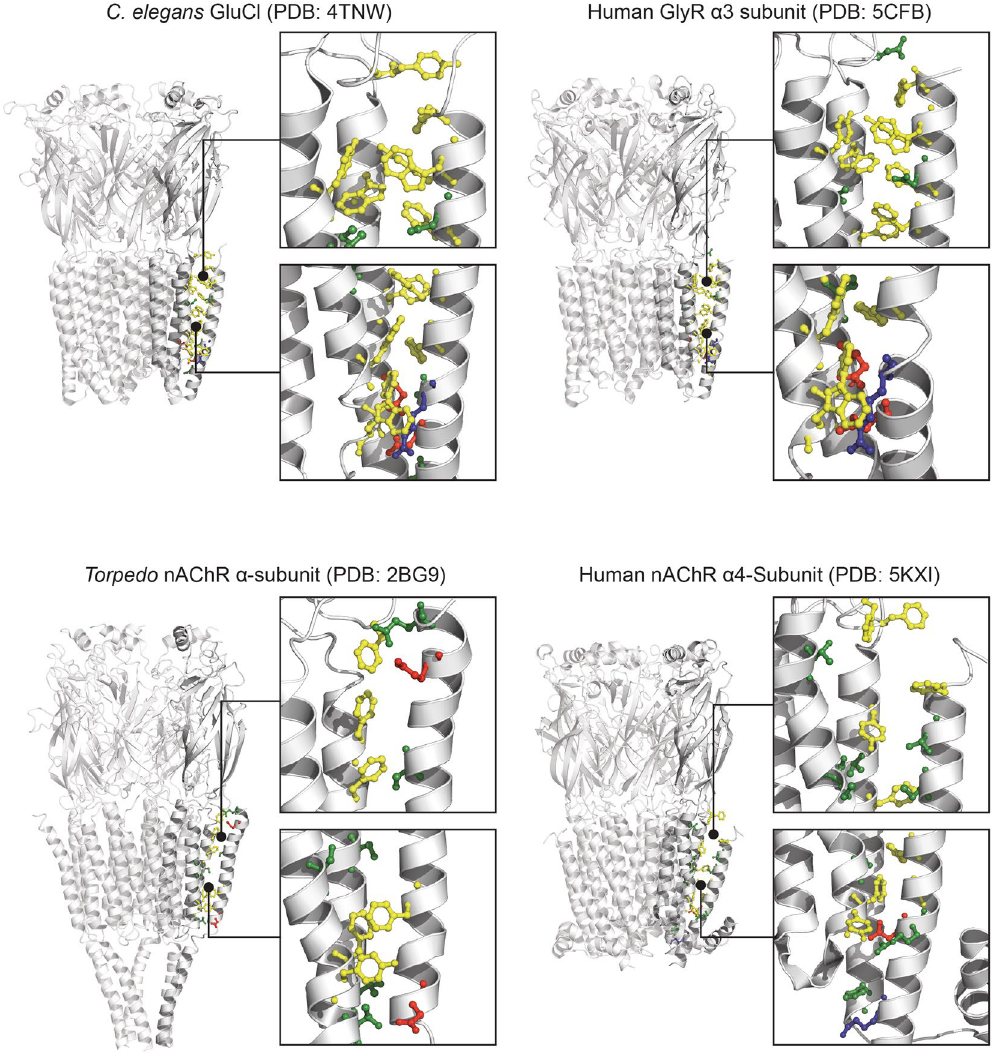
Figure 5. The M4-M1/M3 interface of different pLGICs. Structures of GluCl (top left, PDB: 4TNW), GlyR (top right, PDB: 5CFB), nAChR (bottom left, PDB: 2BG9), and α 4 β 2 (bottom right, PDB: 5KXI). Each structure shows a zoomed in region of the M4-M1/M3 interface of a single subunit. Residues are coloured depending on their properties: aromatic (yellow), hydrogen bonding (green), negatively charged (red) and positively charged